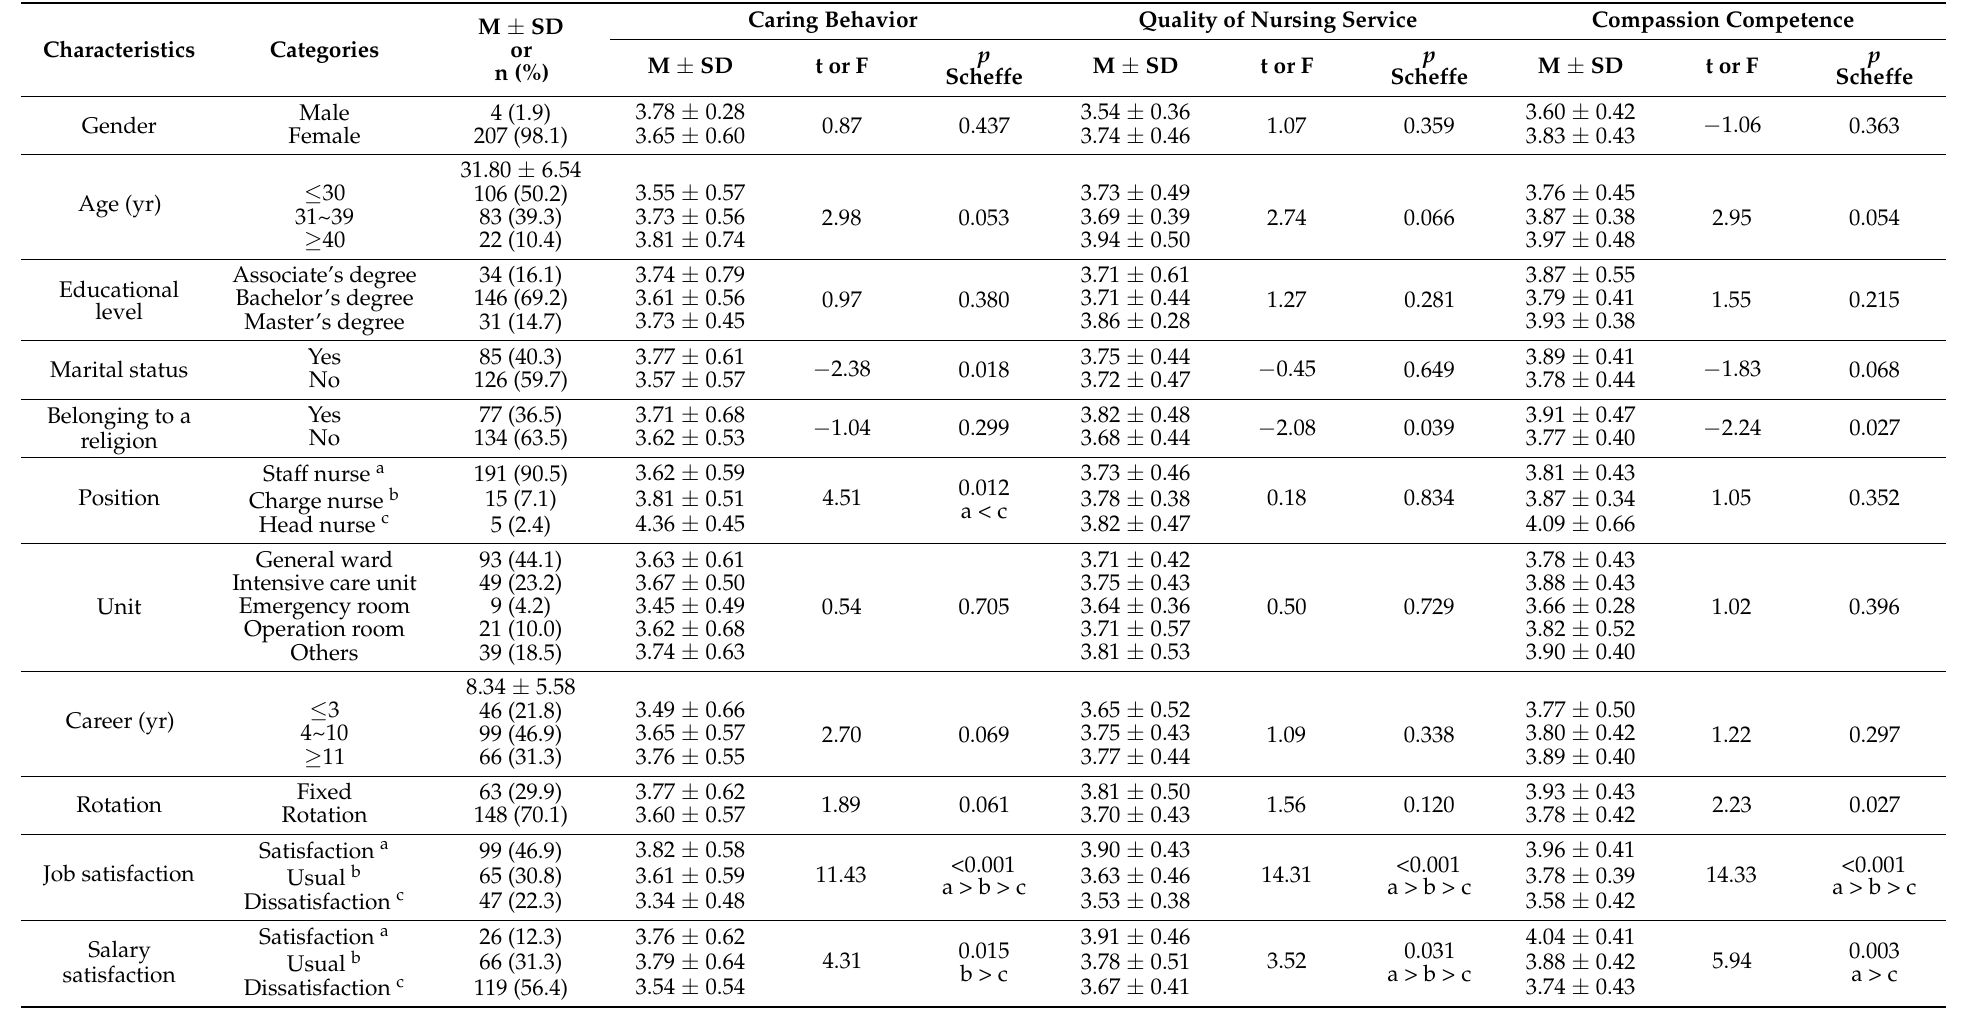
Table 1. Differences in caring behavior, quality of nursing services, and compassion competence according to general characteristics ( N =